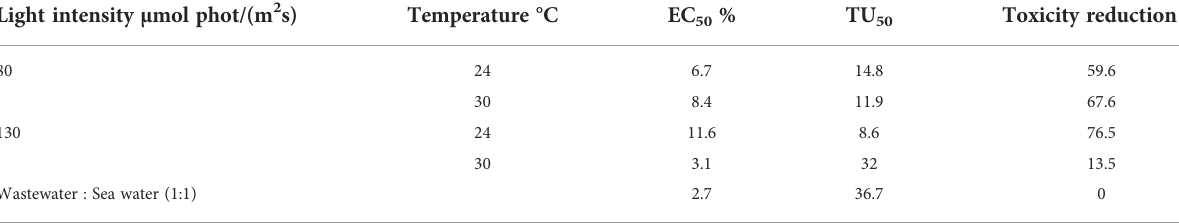
TABLE 5 Microtox ® EC 50 , TU 50 (toxicity units) and percentile of toxicity reduction.